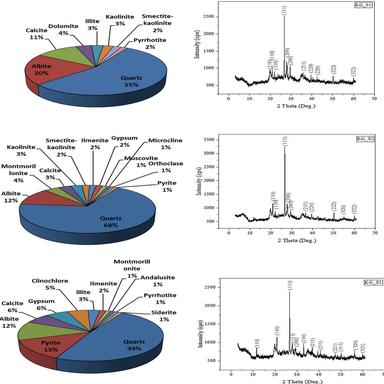
Mineral composition and percentage of KG basin sediment samples obtained through XRD analysis.